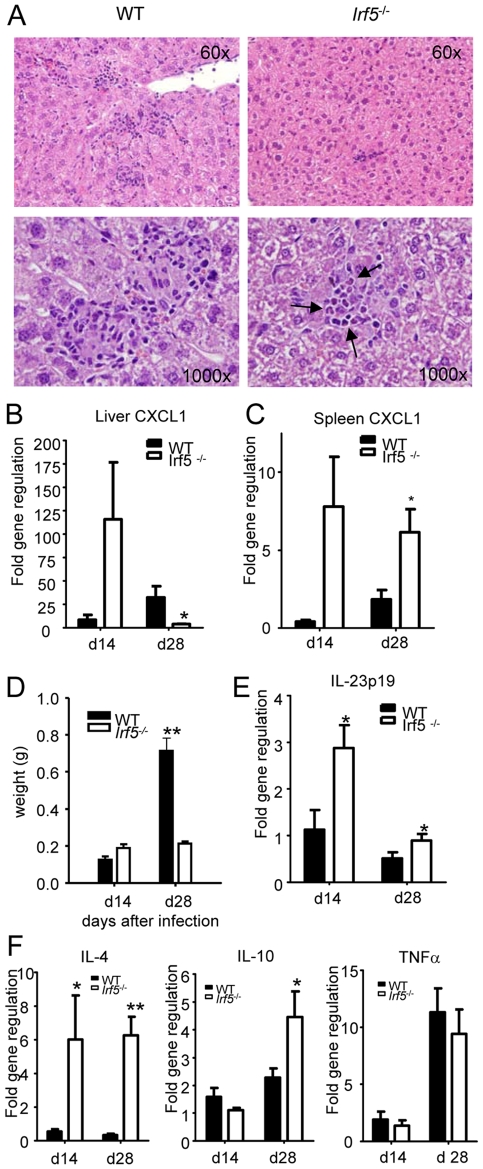

Irf5
-/- mice do not develop Th1-type granulomas.(A) Representative granulomas from H&E stained liver sections at d28 pi in WT and Irf5
-/- mice. Pictures were taken at the indicated magnifications and arrows indicate the presence of neutrophils in the granulomas. (B, C) Real time PCR analysis of the livers (B) and spleen (C) measuring mRNA for CXCL1. (D) Spleen weights at d14 and d28 pi. The body weight of C57BL/6 WT and Irf5-/- mice was comparable. (E) Real time PCR analysis of the livers from infected mice measuring mRNA for IL-23 p19. (F) Real time PCR measurement of cytokine mRNA in the livers of infected mice indicates a skewing toward a Th2 environment. All data is presented as the mean ± SEM combined from two independent experiments. * denotes p<0.05 and ** denotes p<0.01.